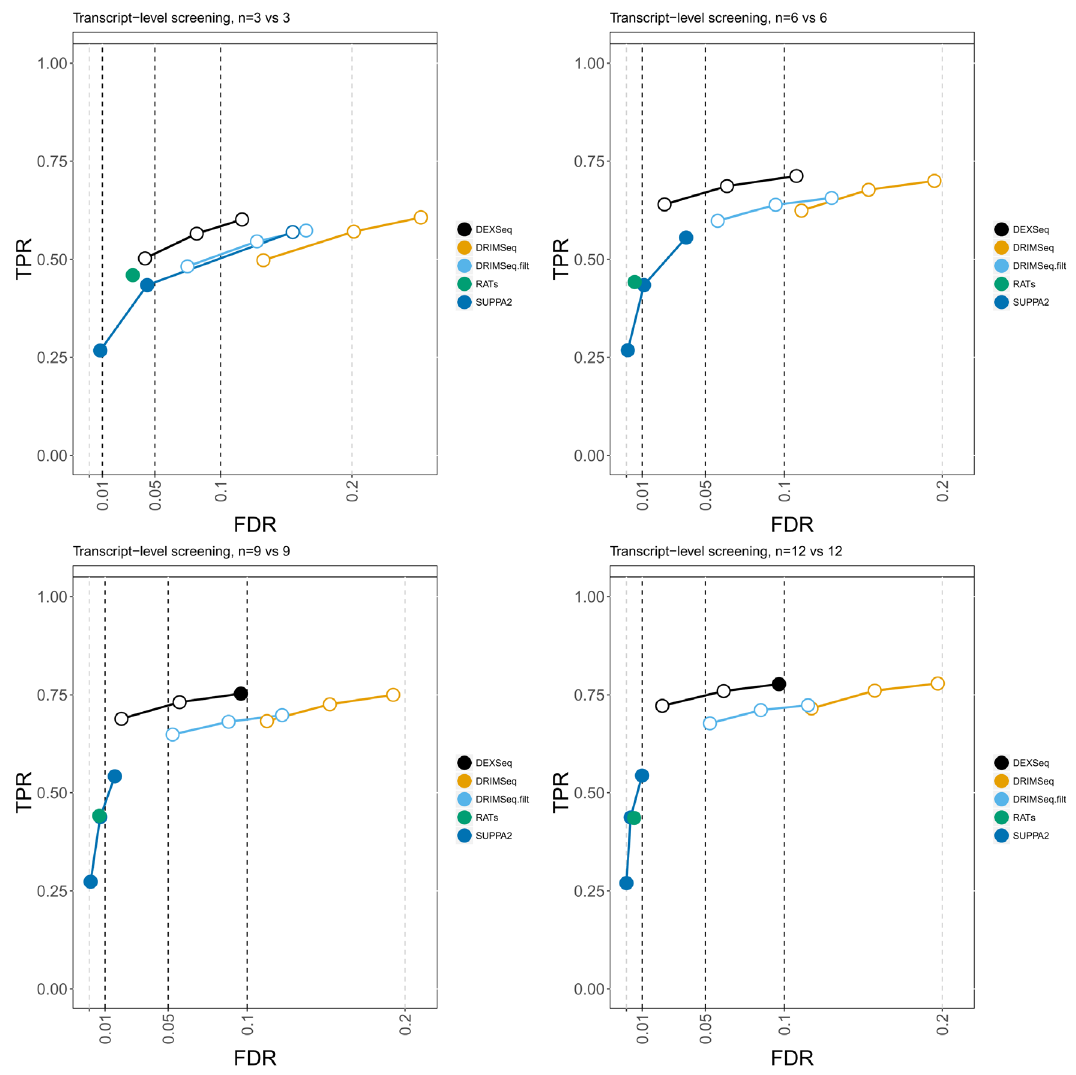
Figure 8. Transcript-level differential transcript usage (DTU) analysis without stage-wise testing. True positive rate (y-axis) over false discovery rate (x-axis) for DEXSeq, DRIMSeq (with and without post-hoc filtering), RATs, and SUPPA2. The four panels are for per-group sample sizes: 3, 6, 9, and 12, as indicated in the title. Circles indicate thresholds of 1%, 5%, and 10% nominal